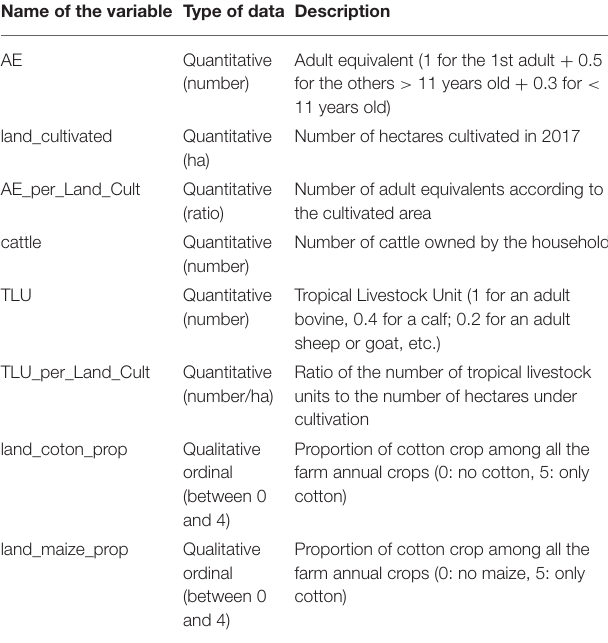
TABLE 2 | Variables extracted from RHoMIS